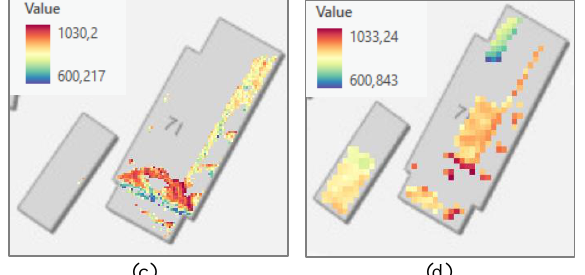
Figure 12. The final result after applying the suitability analysis parameters explained in Table